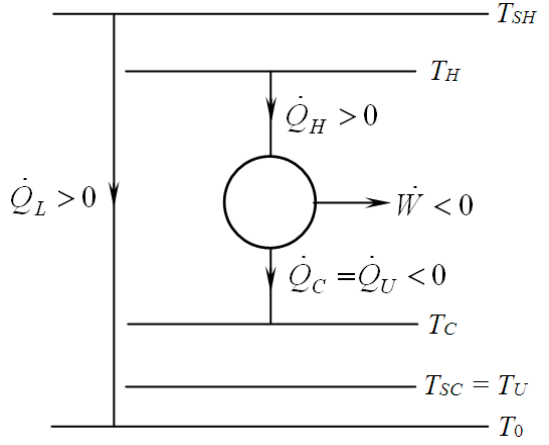
Figure 2. Schematic representation of the temperature distribution in a non-equilibrium CHP Carnot